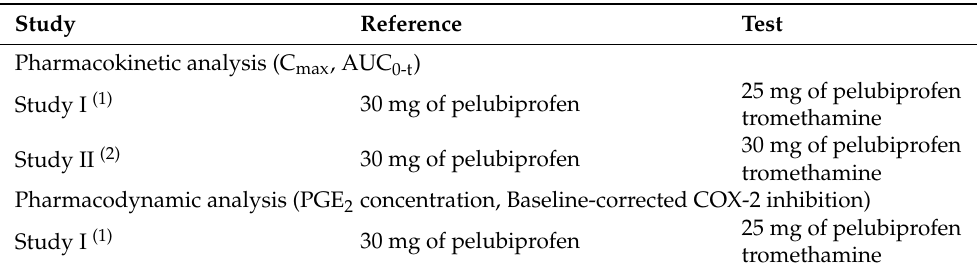
Table 1. Drugs administered and parameters of analysis in both